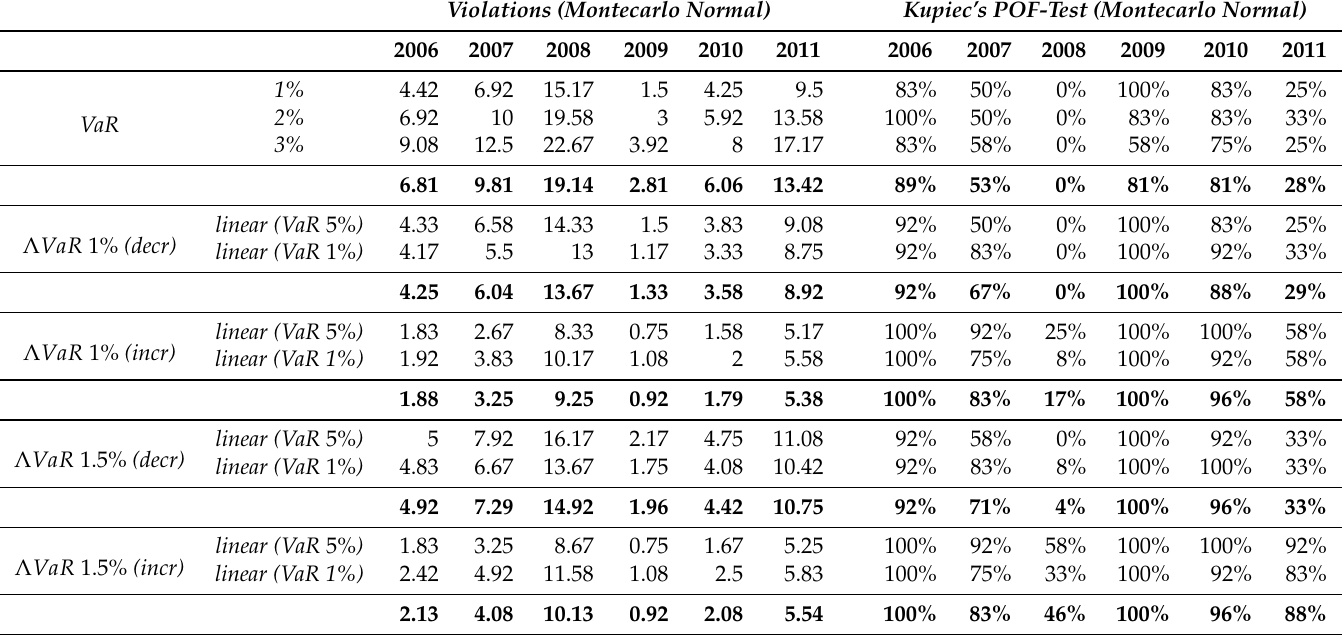
Table 2. Time evolution of the average number of violations and Kupiec test under the Monte Carlo Normal and GARCH models. This table details the evolutions over the global financial crisis of the average number of violations and the percentage of POF acceptance, aggregated at the level of the VaR and the increasing and decreasing Λ VaR